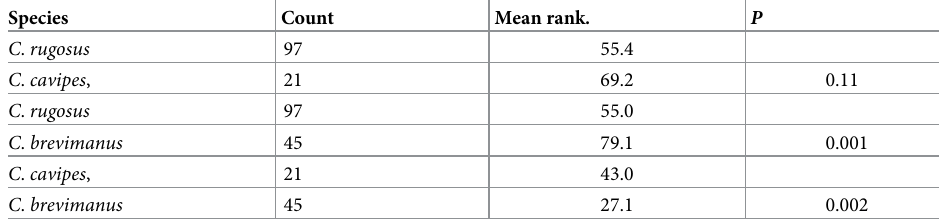
Table 4. Differences in shell preference of three species of terrestrial hermit crabs with overlapping body size (0.7–1.3 cm, shield length) and differences in shell size P = probability (Mann-Whitney test). Species Count Mean rank.